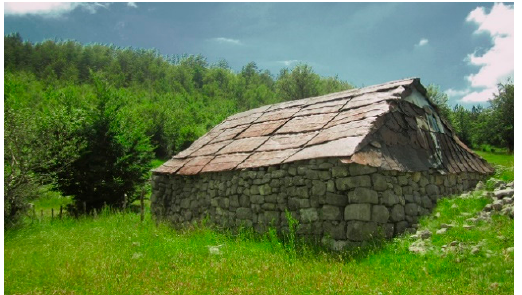
Figure 16. Glada with its face oriented parallel to the terrain, partially dug into the ground—Gra đ en, Podgradski katun, photo: I. Lakovi ć . Land 2020 , 9 , x FOR PEER REVIEW